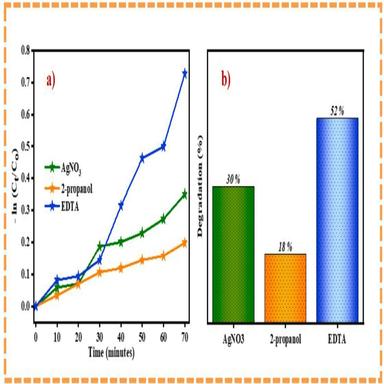
Scavenging plots of Brexin (BX) using scavengers and NF-ldh/MXene (a) –ln (Ct/Co) vs time and (b) percentage degradation.